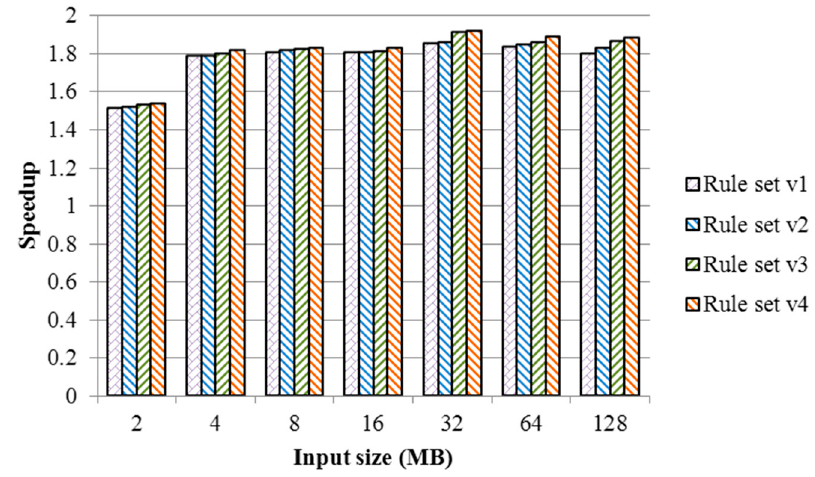
Figure 10. Comparison of speedup between two-phase PFAC and PFAC algorithms with different rule sets and input sizes on GTX TITAN X workstation.